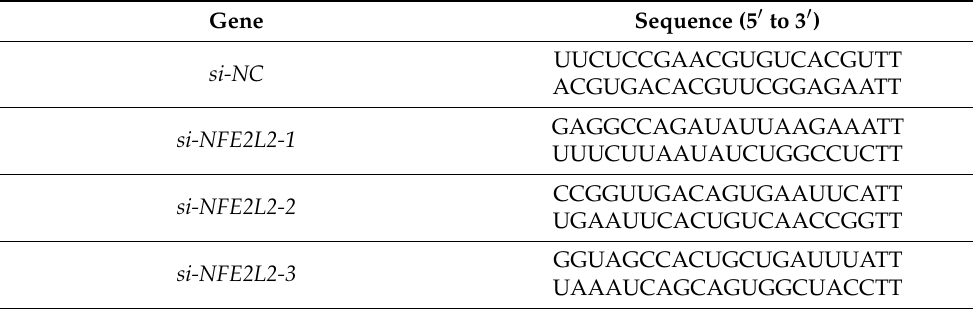
Table 3. Oligos for